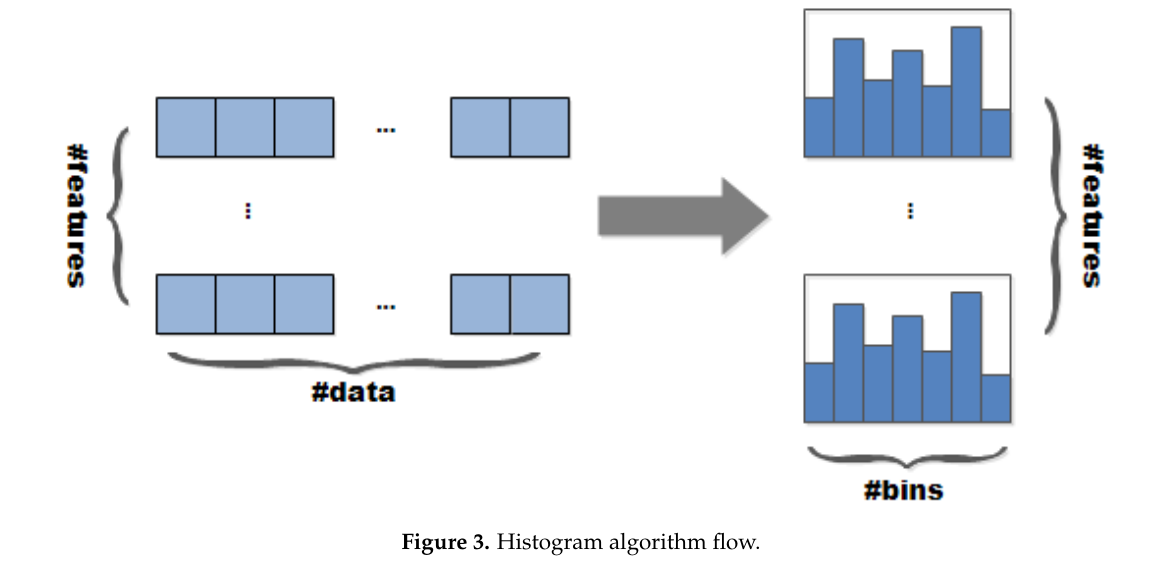
Figure 3. Histogram algorithm flow.